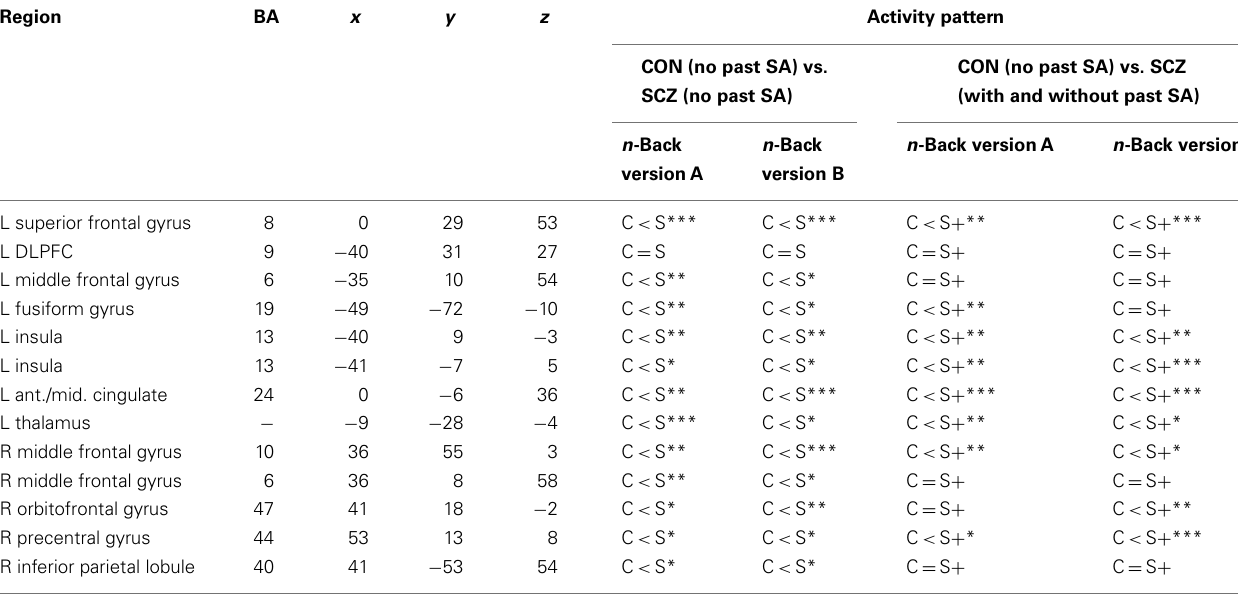
Table 6 | Post hoc analyses examining the source of interaction effects between diagnostic group and past substance abuse . Region BA x y z Activity